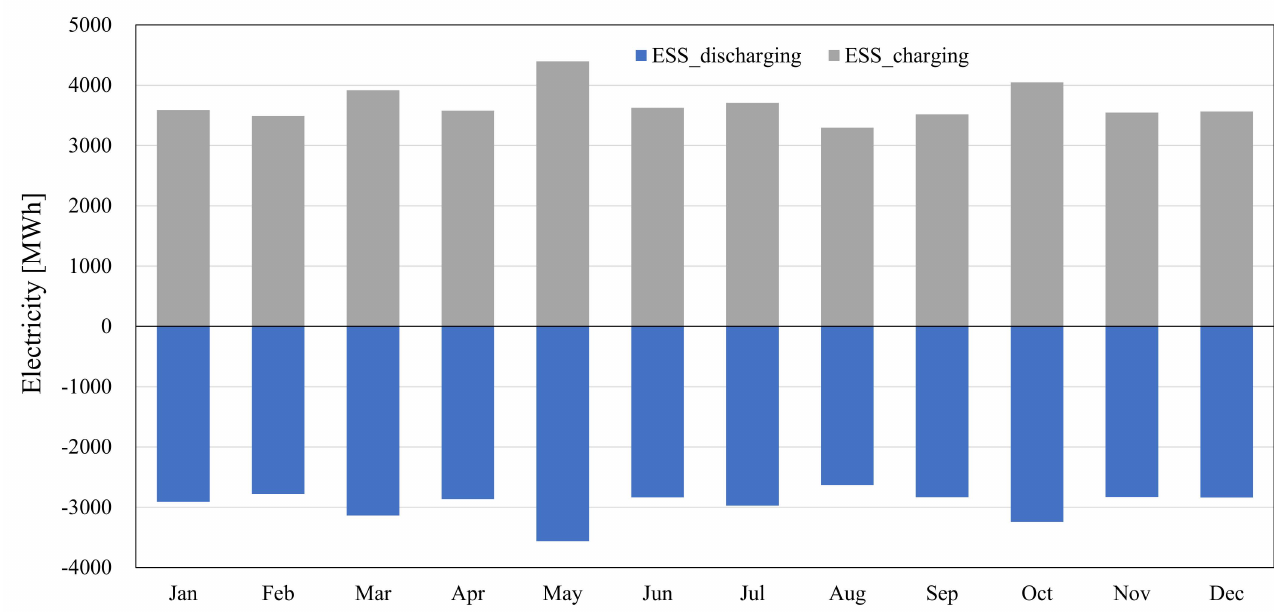
Figure 10. Monthly operating profile of ESS.